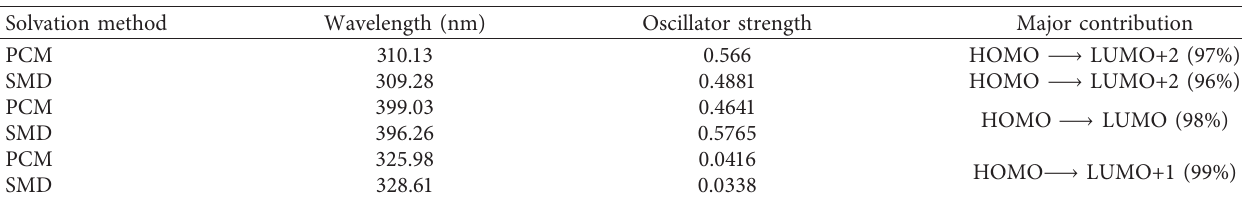
Table 2: The main peaks in the electronic spectrum for ibrutinib calculated by time-dependent density functional theory (B3LYP-6- 311G++(d,p)) in methanol using two different solvation methods: polarizable continuum model (PCM) and solvation model based on density